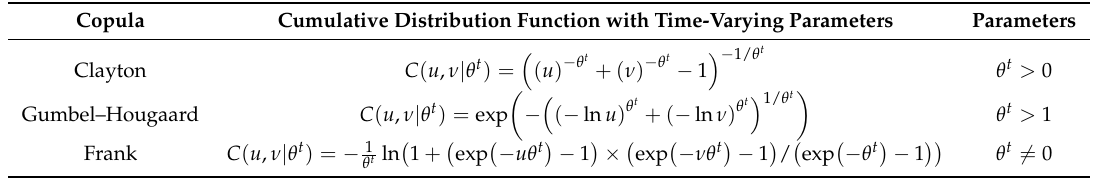
Table 1. The applied time-varying bivariate copulas in this